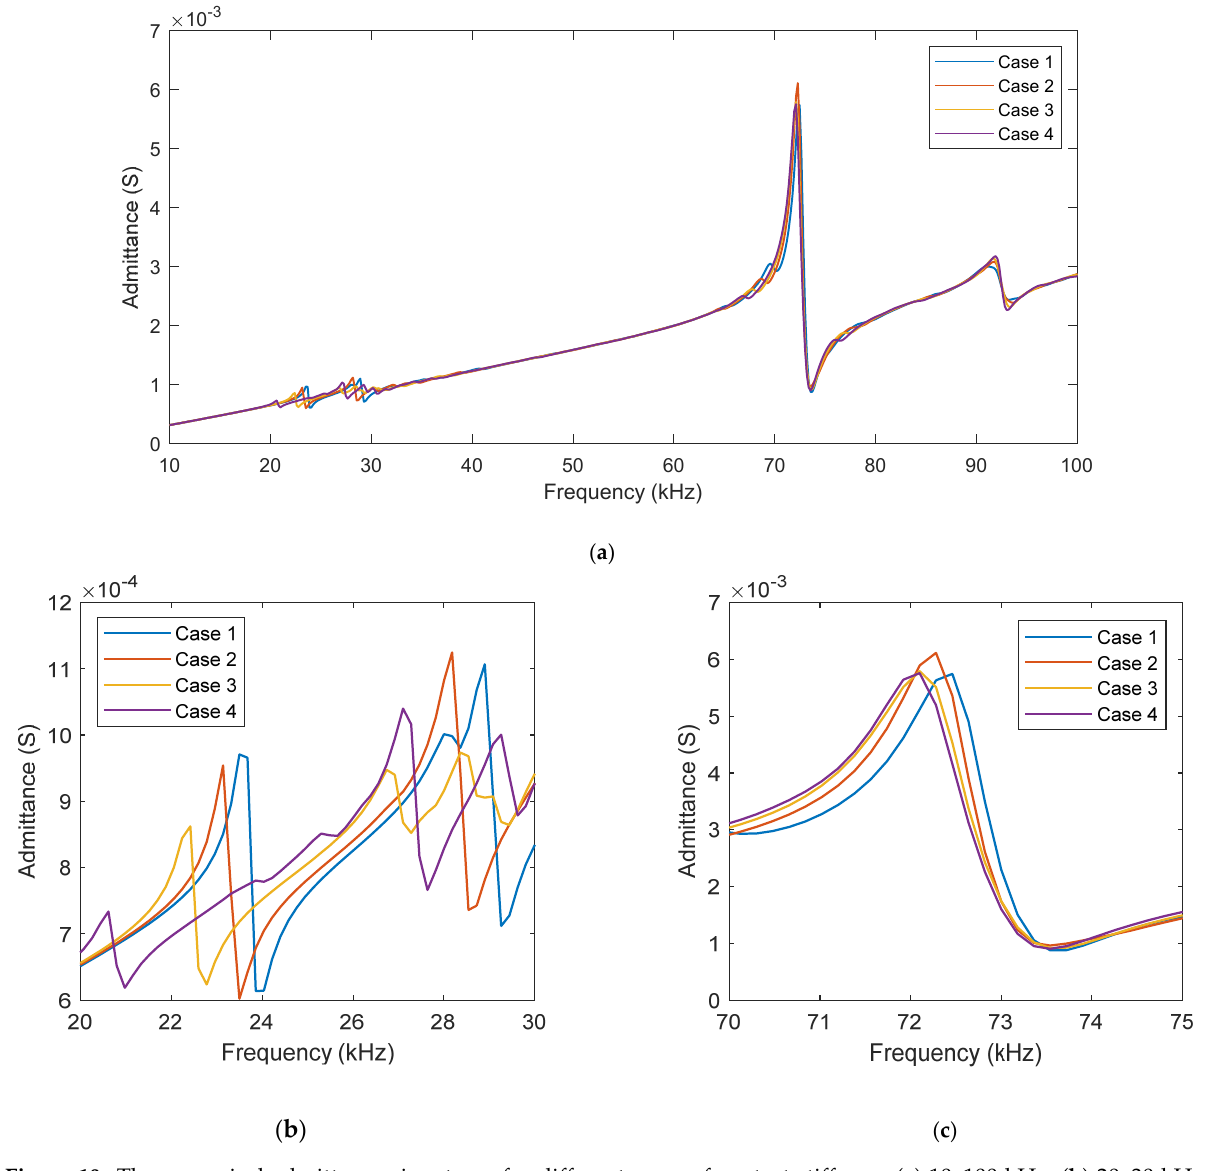
Figure 10. The numerical admittance signatures for different cases of contact stiffness. ( a ) 10–100 kHz; ( b ) 20–30 kHz; ( c ) 70–75 kHz.